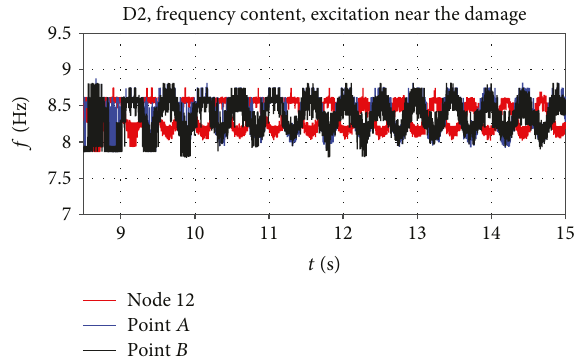
Figure 61: Undamaged case, excitation far from the damage.